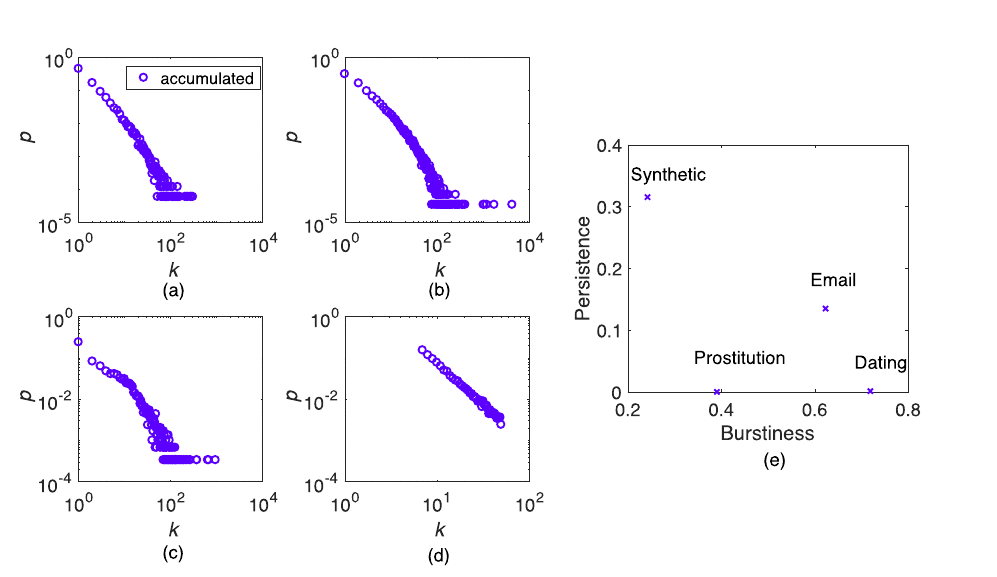
Figure 1. The statistical characteristics of the temporal networks. In panels (a–d), we plot the probability density p as a function of degree k (( a ) Prostitution network, ( b ) Dating network, ( c ) Email network and ( d ) Synthetic network). We plot results for the accumulated network of all contacts. In panel (e), we show the temporal statistics of the datasets—persistence and